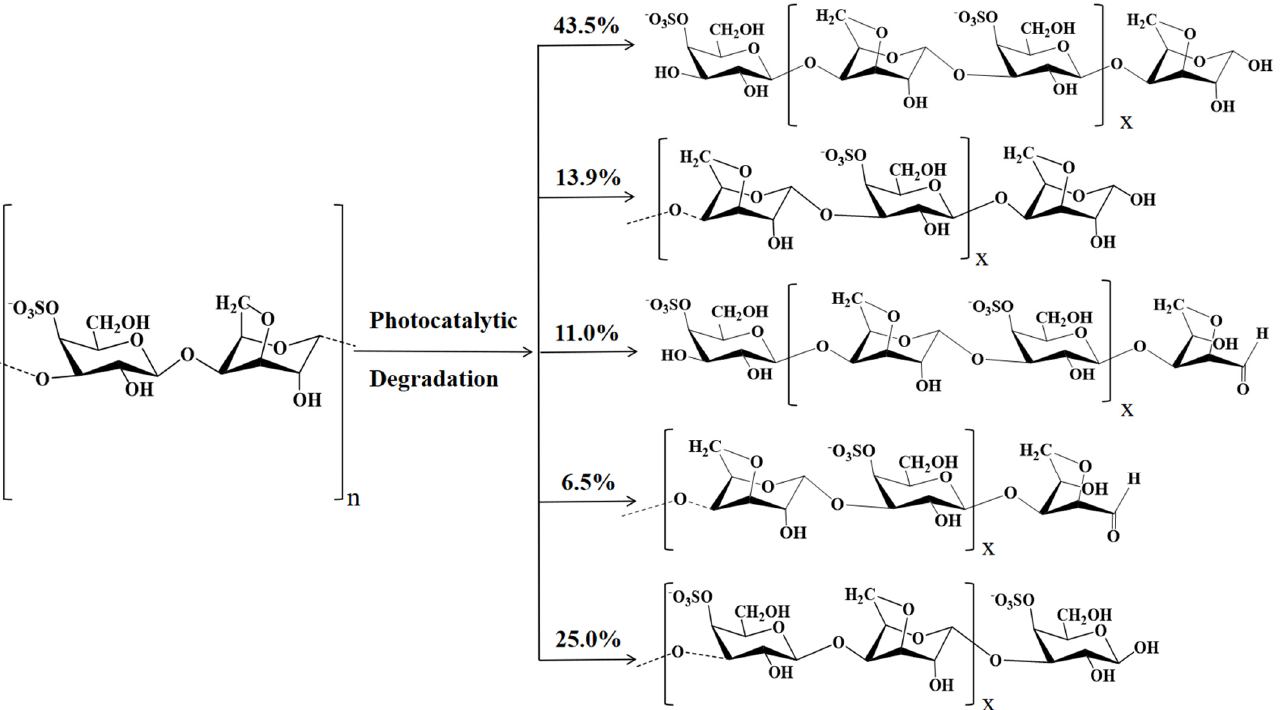
Figure 8. Carrageenan oligosaccharides produced during photocatalytic reaction (x = 0, 1, 2,